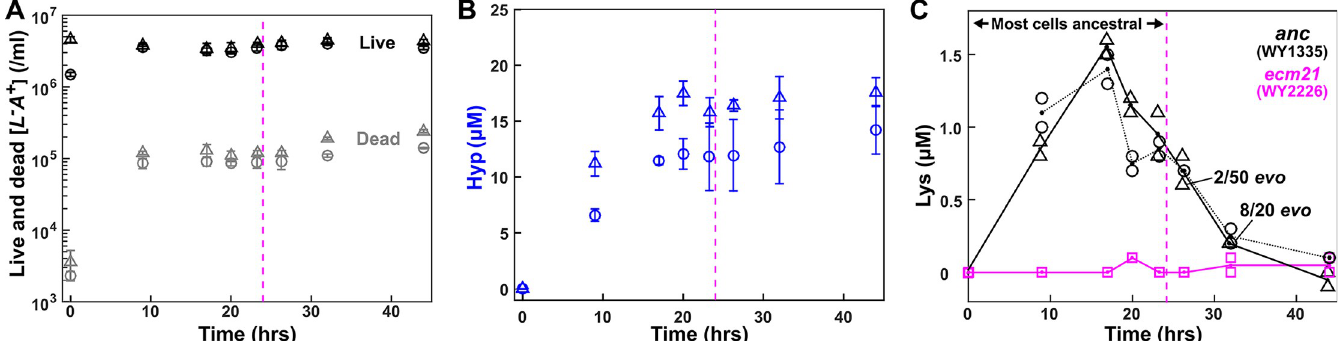
Fig 3. Chemostat dynamics reveals rapid evolution. L − A + (WY1335) cells growing exponentially in excess lysine were washed free of lysine and inoculated into the culturing vessel (triangles: inoculation at near steady-state density in the absence of lysine; circles: inoculation at 1/3 steady-state density in the presence of 5–10 μ M lysine). Minimal medium containing 20 μ M lysine was dripped into the culturing vessel (19 mL) to achieve an 8-h doubling time (19 mL � ln(2)/8 h = 1.646 mL/h; “Chemostat culturing” in Methods). ( A ) Live and dead cell densities (Methods, “Flow cytometry”) and ( B ) released hypoxanthine (Methods, “Bioassays”) reached steady state by about 10 h and about 20 h, respectively. Error bars represent 2 standard deviations. ( C ) Lysine concentrations in culturing vessels failed to maintain a steady state due to rapid evolution (Methods, “Detecting evolved clones”). Instead, lysine concentrations rapidly declined to a level similar to that in a chemostat inoculated with an L − A + mutant with improved affinity for lysine [43,53] (“ ecm21 ,” magenta). Indeed, when we tested chemostat samples (triangles), 8 out of 20 tested clones were evolved by 32 h (about four generations). For each sample, two measurements of lysine concentrations and their average were plotted. Magenta dashed lines mark the time before which > 90% of population remained ancestral. All plotted data are in S3 Data. anc , ancestor; evo , evolved; ecm21 , a strain harboring a deletion mutation of the ECM21 gene; Hyp, hypoxanthine; Lys, lysine.